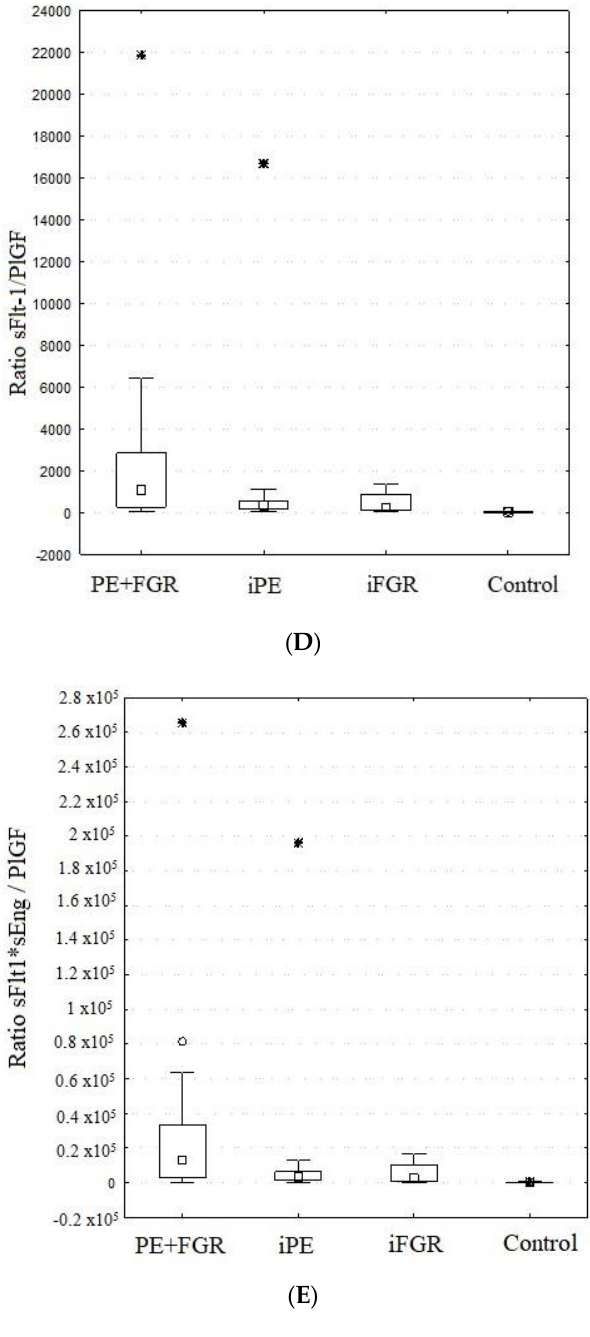
Figure 1. ( A – E ) Box and whisker plots for serum concentrations of sEng, sFlt-1, PlGF and sFlt-1/PlGF and sFlt-1*sEng/PlGF ratios in study groups: PE+FGR (preeclampsia with concurrent FGR), iPE (isolated PE), iFGR (isolated, normotensive FGR) and healthy control patients. Boxes indicate interquartile range; whiskers indicate range; square bars indicate median, asterisks indicate extreme values.